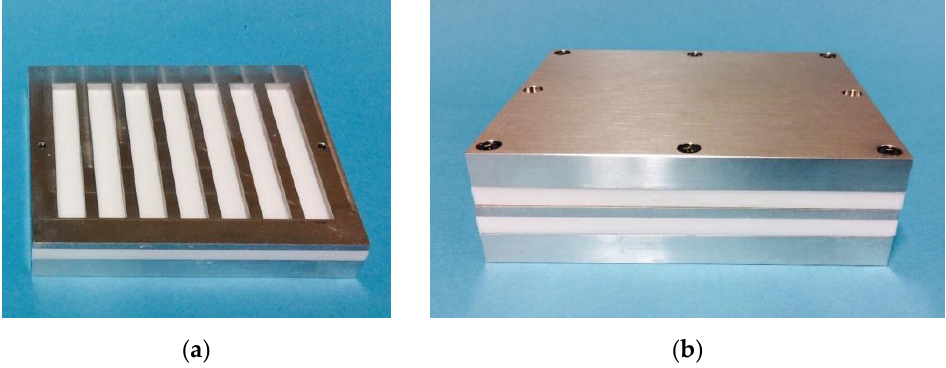
Figure 1. The molds to form the specimens, ( a ) Bottom plate, PTFE (polytetrafluoroethylene) plate, polyester film, and molds plate, ( b ) closed form adding another PTFE plate and the top plate.